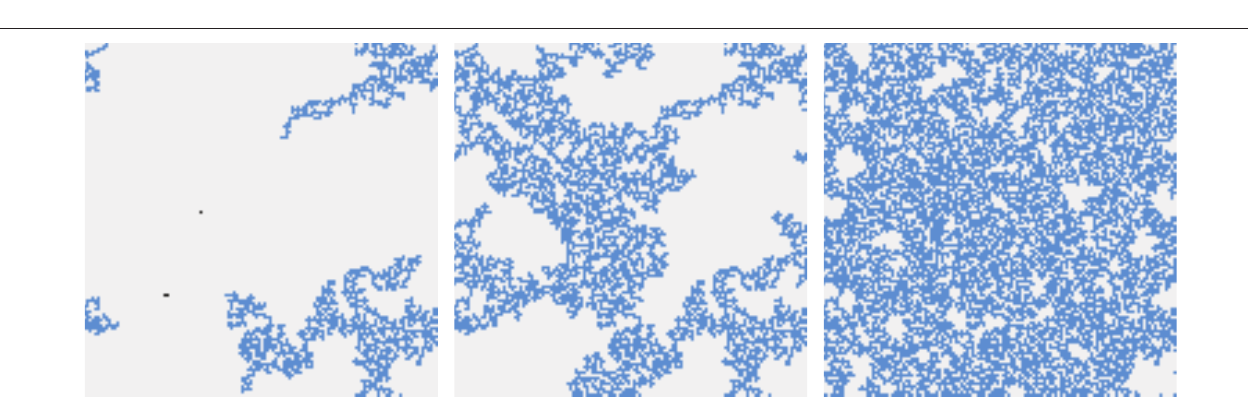
FIGURE 6 | Hole structure of a square lattice ( N = 128 2 ) LLS fiber bundle with a uniform threshold distribution on [0.5,1] at three different damages: k / N = 0.1 (left), k / N = 0.3 (middle), and k / N = 0.59 (right). Intact fibers are light gray, the largest hole is blue, and other broken fibers are black. From early on in the breaking process a single hole is growing